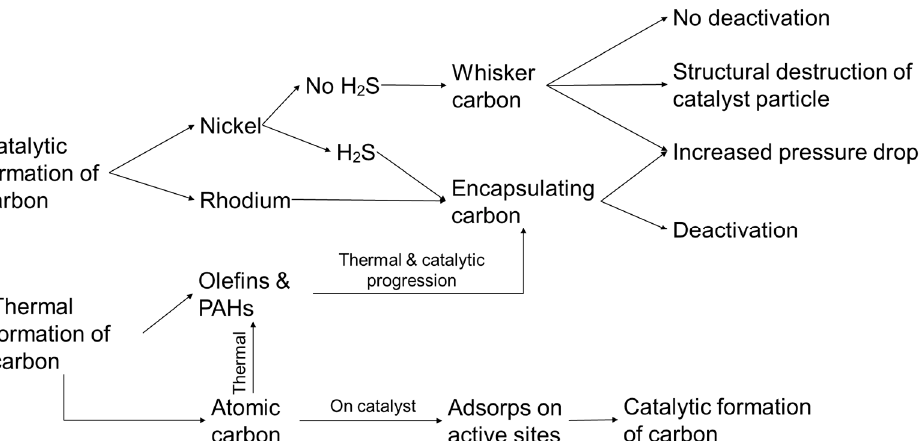
Figure 1. Different options for carbon formation from catalytic and thermal reactions and the resulting effect on the catalytic reactor.